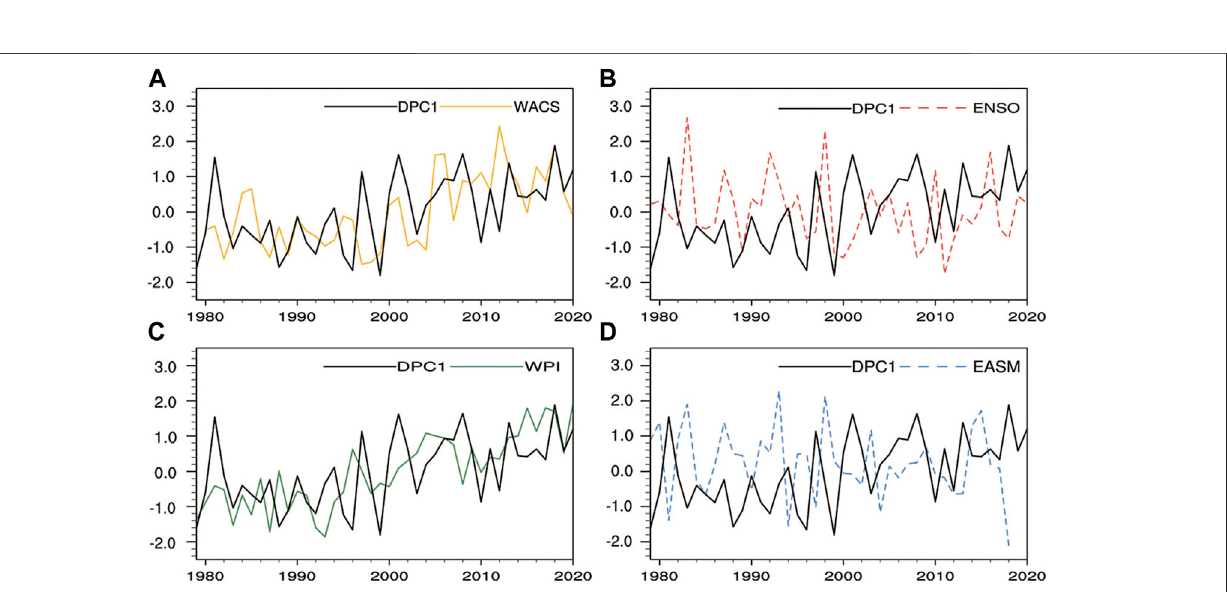
Frontiers in Earth Science |